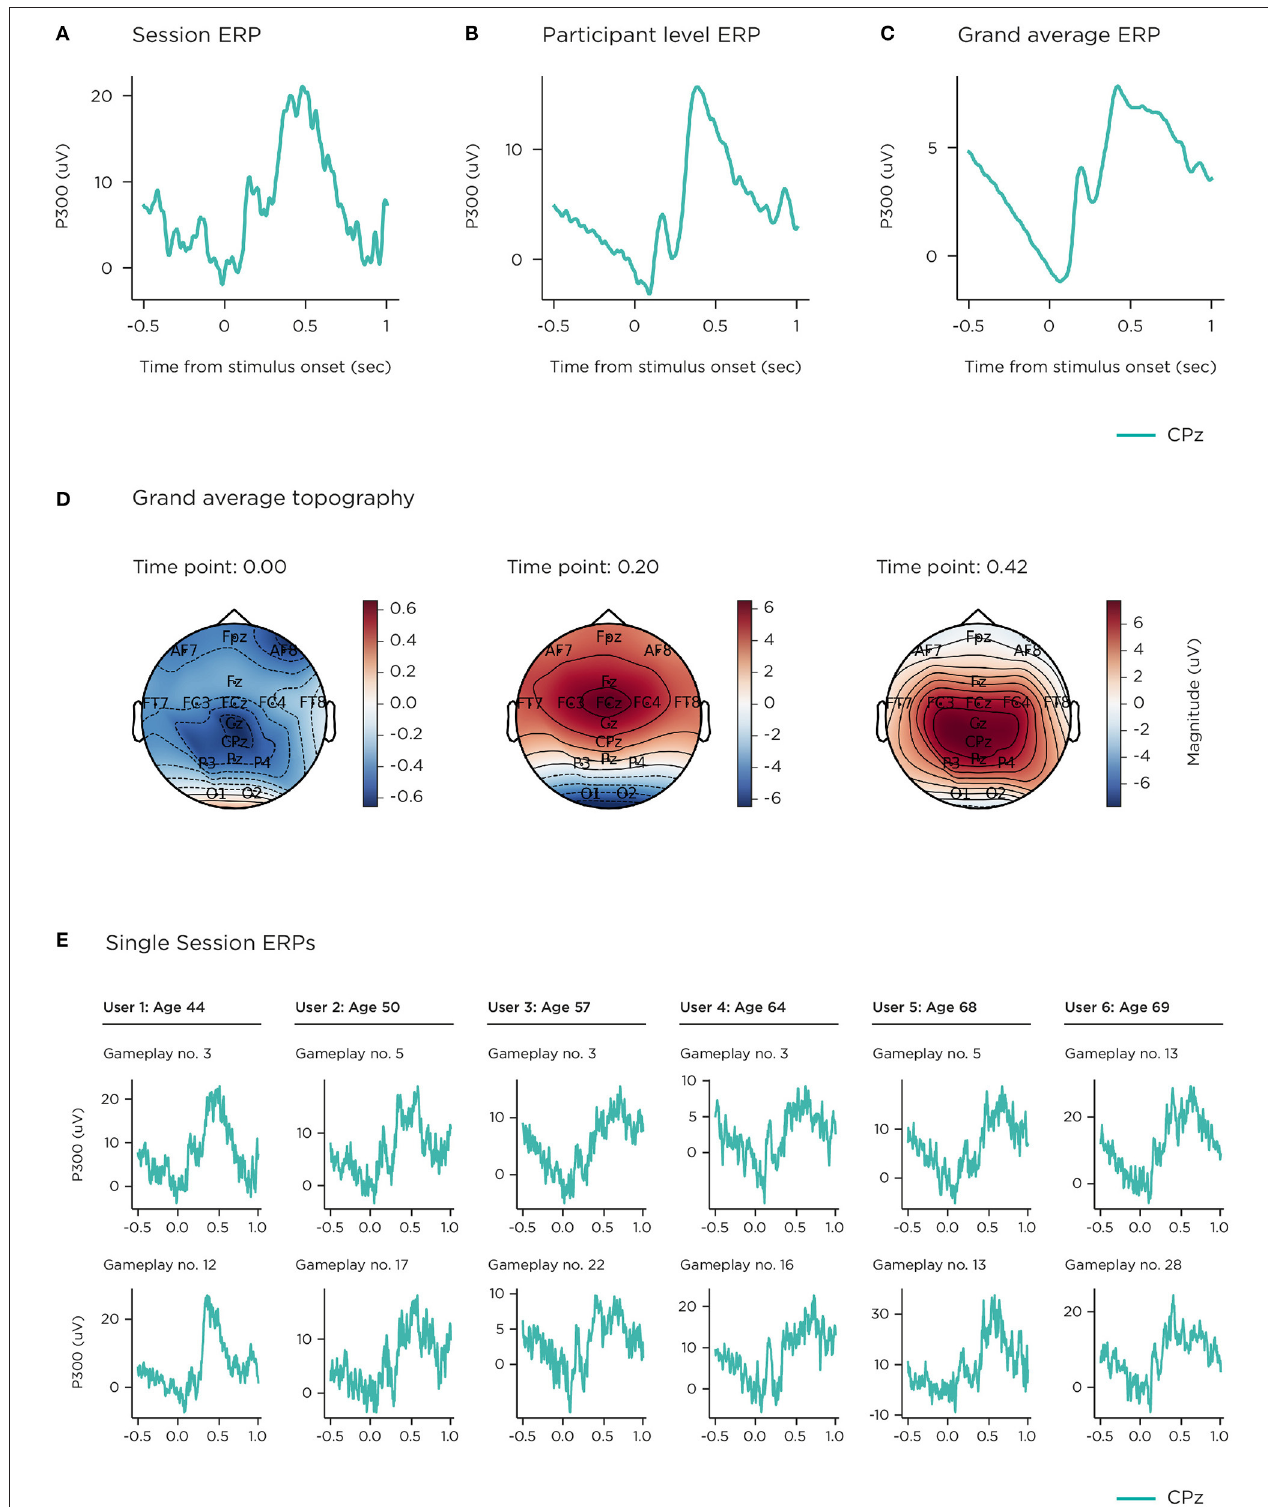
FIGURE 8 | P300. (A) single-session median; (B) single-participant mean; (C) grand mean; (D) grand mean topographies selected at ERP peak timepoints; (E) examples of single-session median ERPs successfully recorded from game plays from 6 different participants (2 participants per age group).